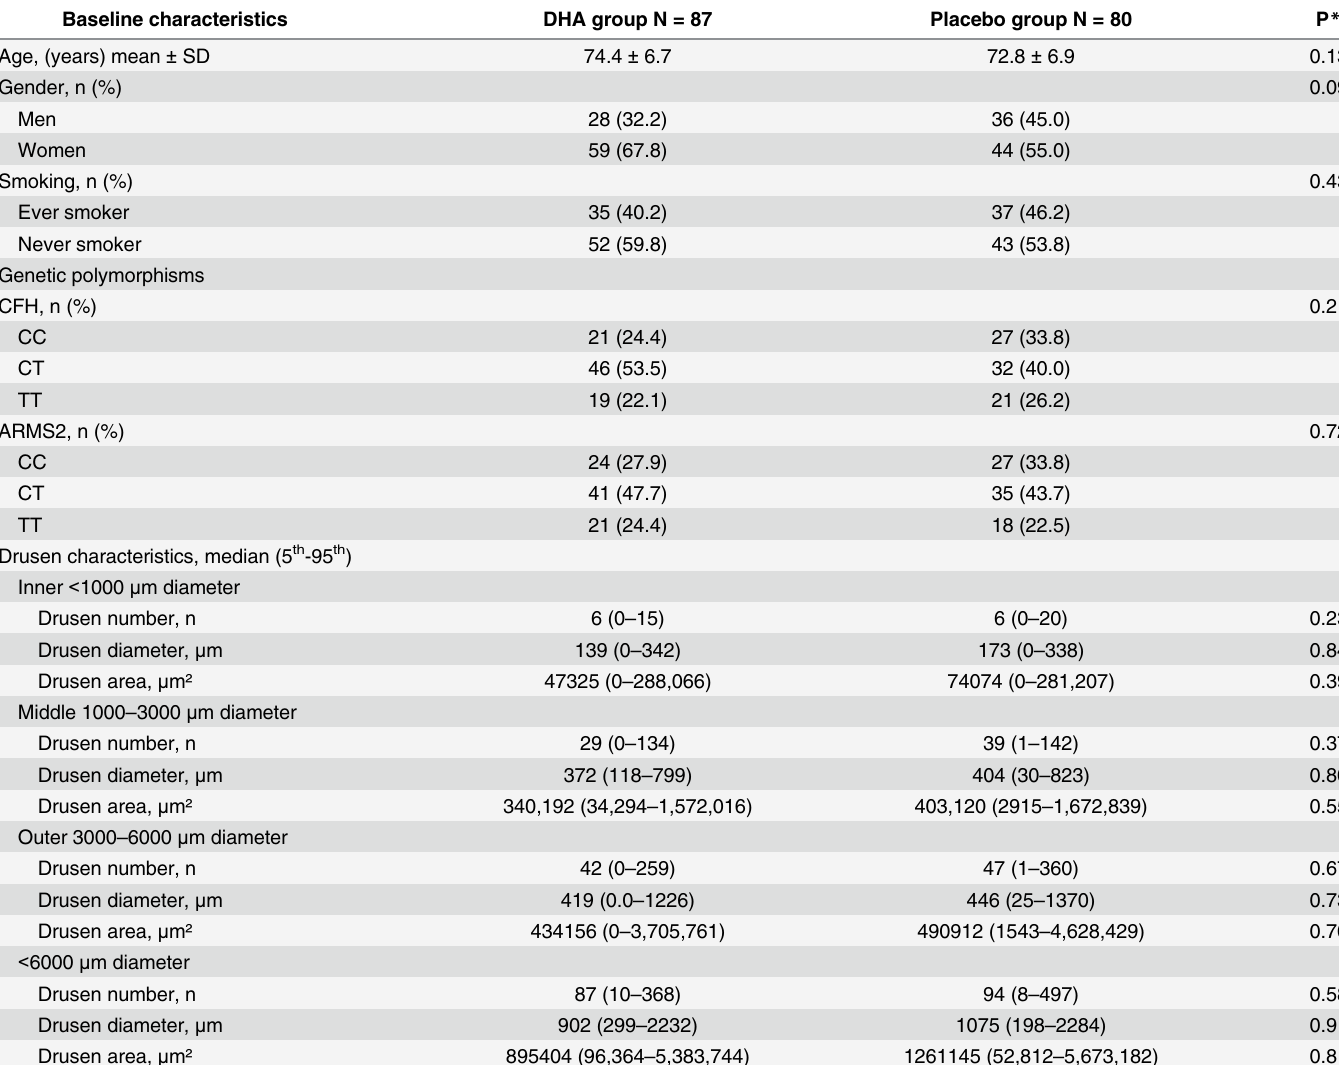
Table 1. Socio-demographic, genetics and drusen characteristics at